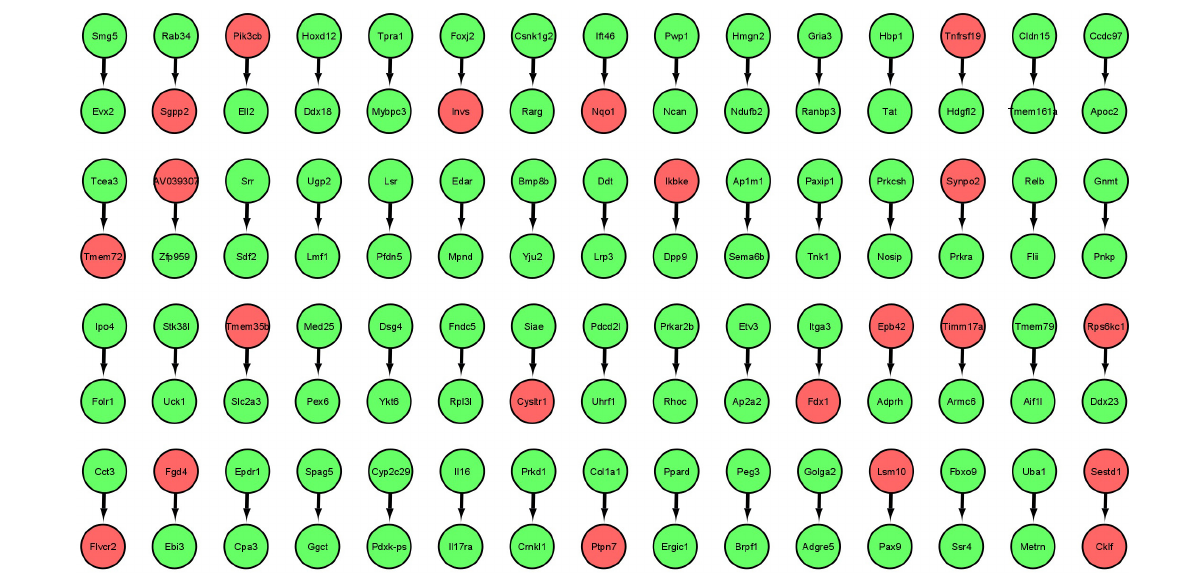
Frontiers in Cell and Developmental Biology |